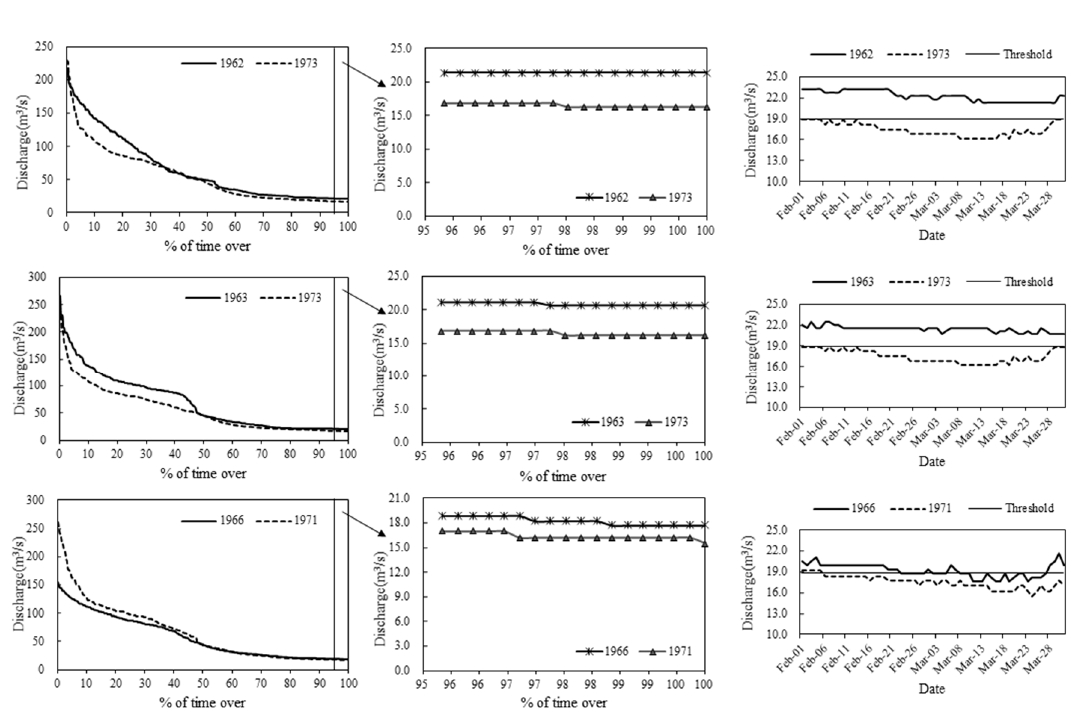
Figure A1. Flow duration curves for all selected pairs in Phase 1 and Phase 2.